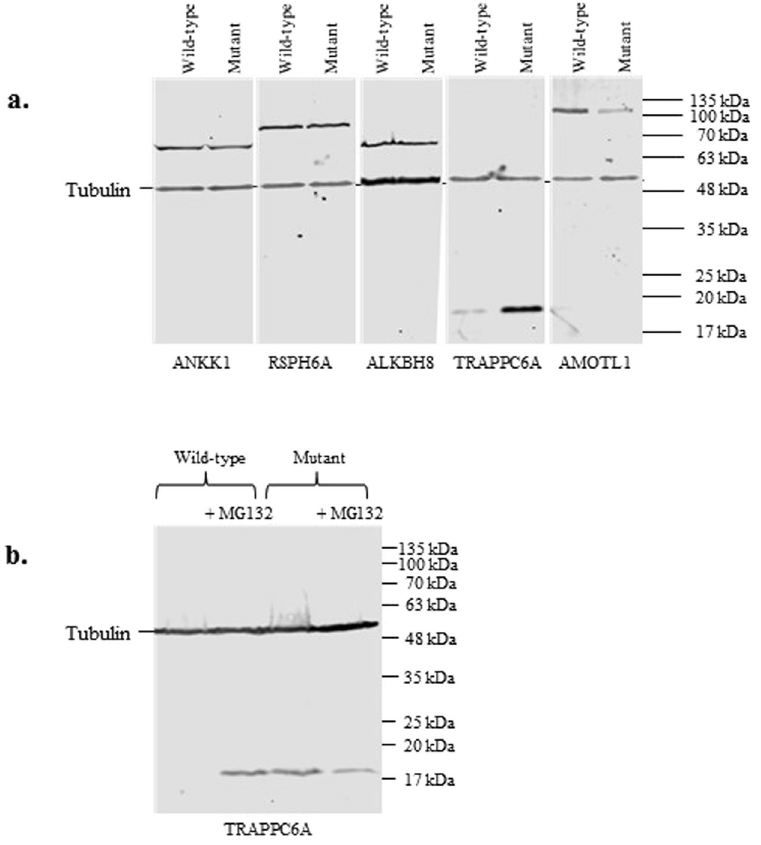
Figure 4. ( a ) Western blot of HEK293 cells transfected with constructs corresponding to the wild-type or mutant forms of all five proteins (AMOTL1, ALKBH8, RSPH6A, ANKK1, TRAPPC6A). ( b ) Western blots following addition of proteasomal inhibitor MG132 to HEK293 cells transfected with wild-type or mutant constructs for TRAPPC6A or AMOTL1. Tubulin is used as a loading control. A reference size ladder corresponding to the molecular weights is included. This figure was generated by cropping the original Western blots which are available on request.